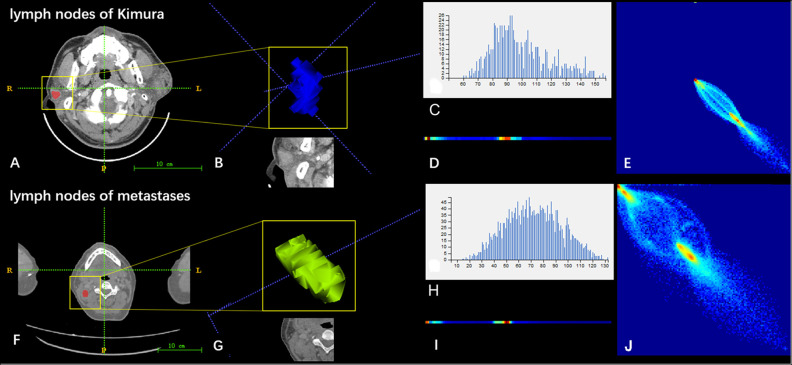
Two sets of mapped images of radiomic features of patients with Kimura disease (A–E) and lymph node metastases (F–J). (A,F) CECT images. (B,G) Volumes of interest. (C,H) Grayscale distribution histogram of the lesions. The distribution of (H) was more dispersed than the distribution of (C). (D,I) Run length matrix features. The frequency of changing of the gray scale of (D) was smaller than that of (I). (E,J) Gray level co-occurrence matrix features. The heterogeneity of lesions in (J) was greater than that of (E).